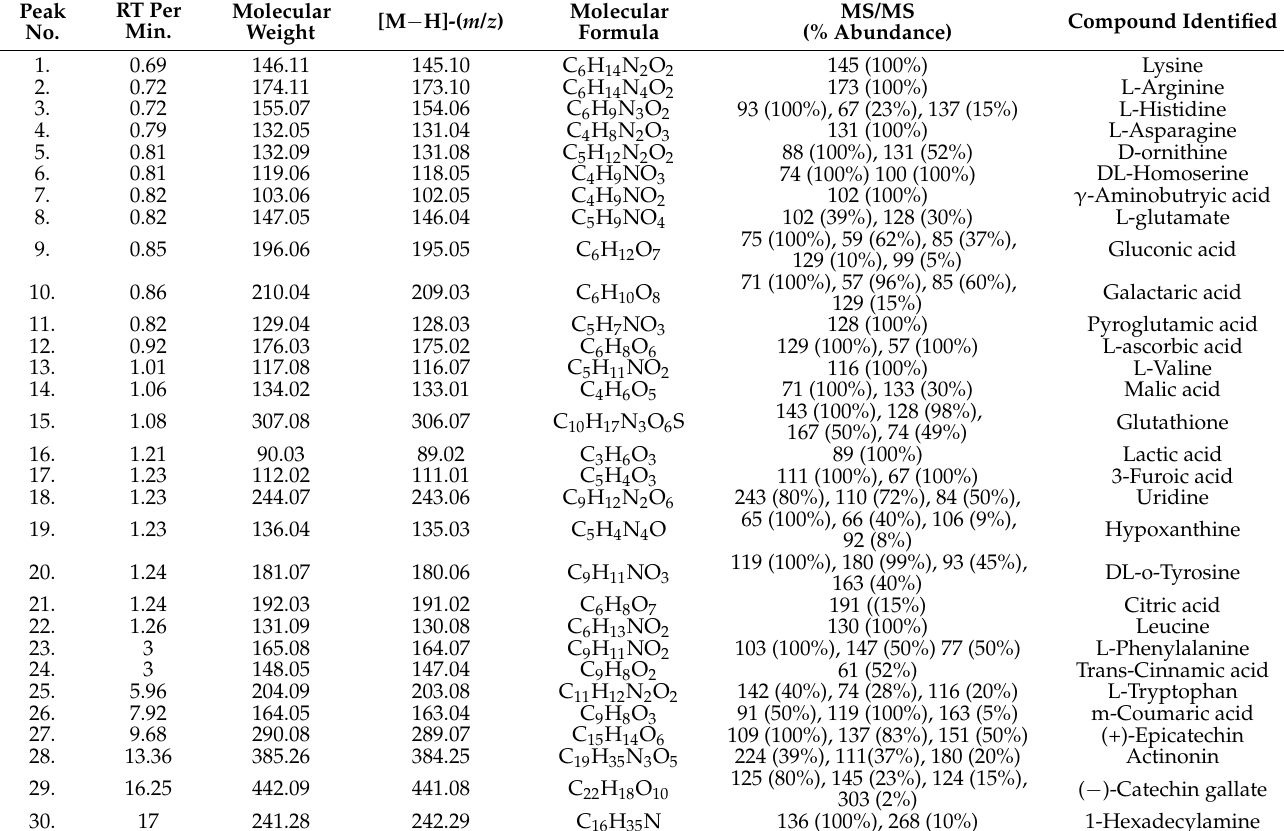
Table 2. Metabolites that were identified in the ethanol extracts of alfalfa and buckwheat sprout extracts by UHPLC-Q-TOF- MS 2 . RT, retention time. Peak